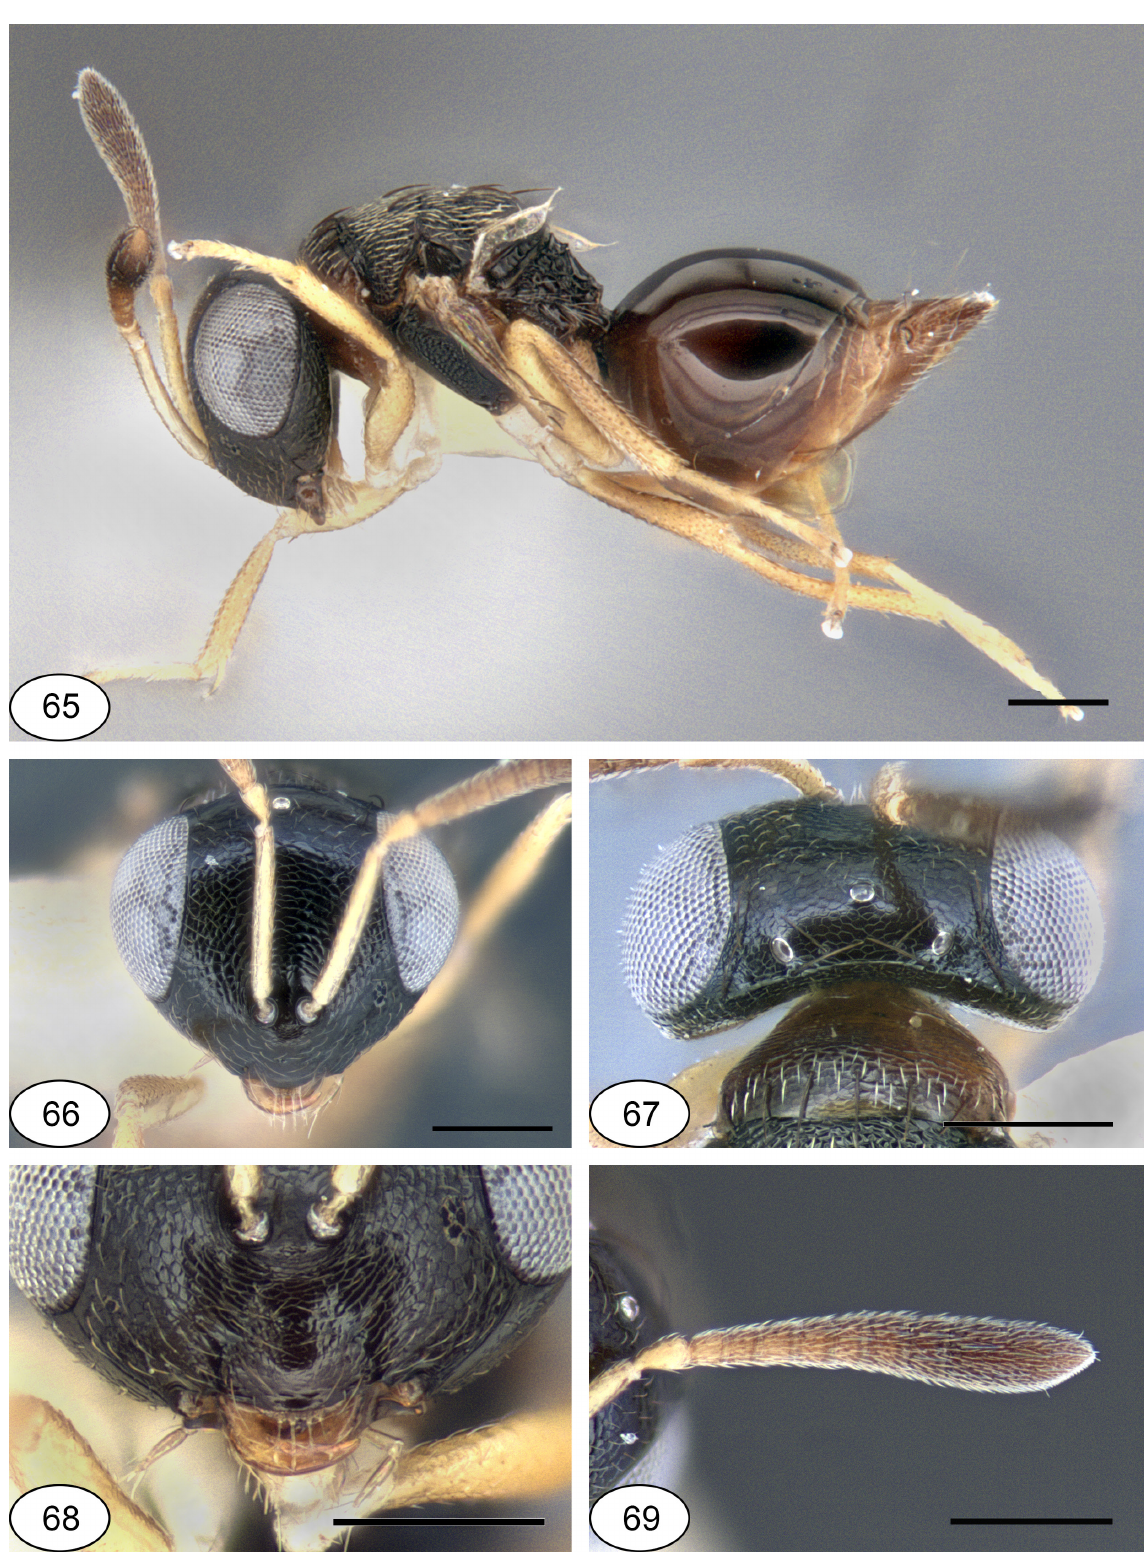
Figs 65–69. Netomocera formiciformis sp. nov., holotype, ♀. 65 . Habitus, lateral view. 66 . Head, frontal view. 67 . Head, dorsal view. 68 . Lower face. 69 . Antenna. Scale bars: 0.2